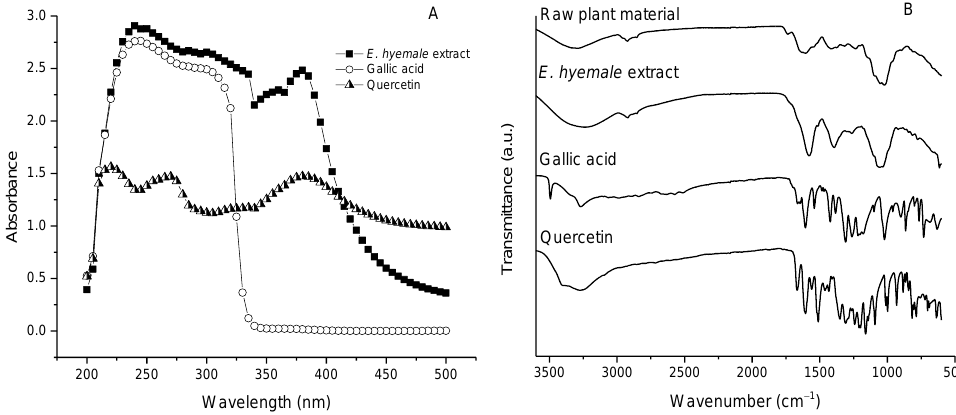
Figure 3. ( A ) UV/Vis absorption spectrum of E. hyemale extract, gallic acid, and quercetin. ( B ) FTIR spectrum of raw plant material of E. hyemale extract, quercetin, and gallic acid.